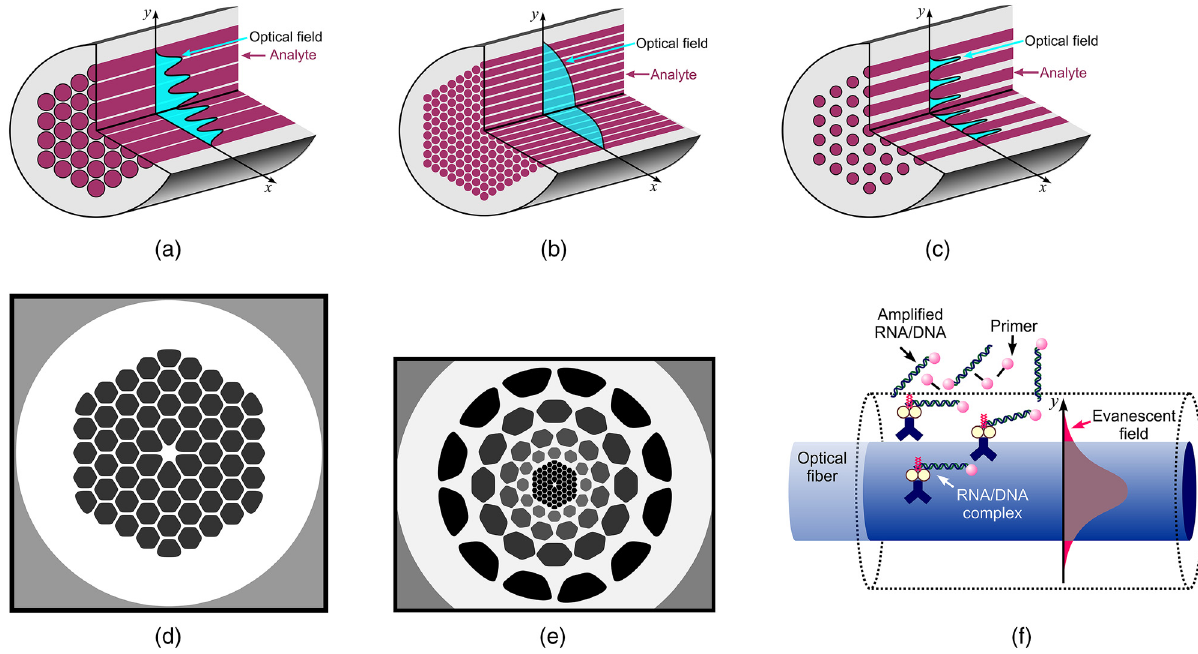
Figure 2: Schematics of the multichannel fiber sensor (a – c) and optical fiber structures (d, e) designed for the sensor. Shown in (f) is a fiber optic fluorometric sensor for the detection of polymerase chain reaction (PCR) – amplified DNA